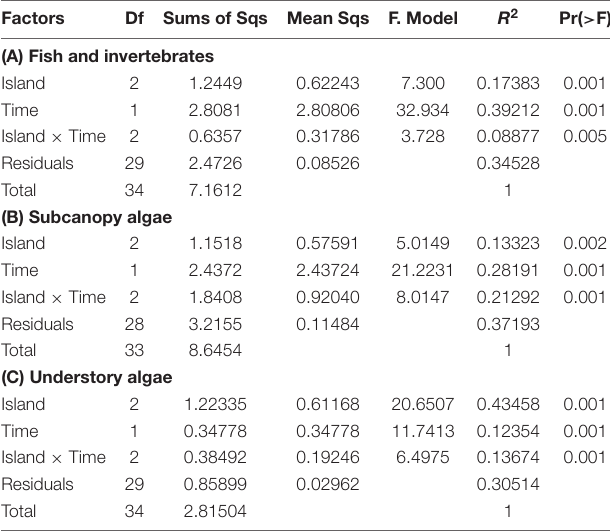
TABLE 2 | Results from the analysis of multivariate variance for PERMANOVAs of response variables as a function of the crossed factors Island and Time based on Bray-Curtis distance matrices derived from square-root transformed data, for (A) density of fish and invertebrate, (B) relative abundance of subcanopy algae, and (C) percent cover of understory algae species per